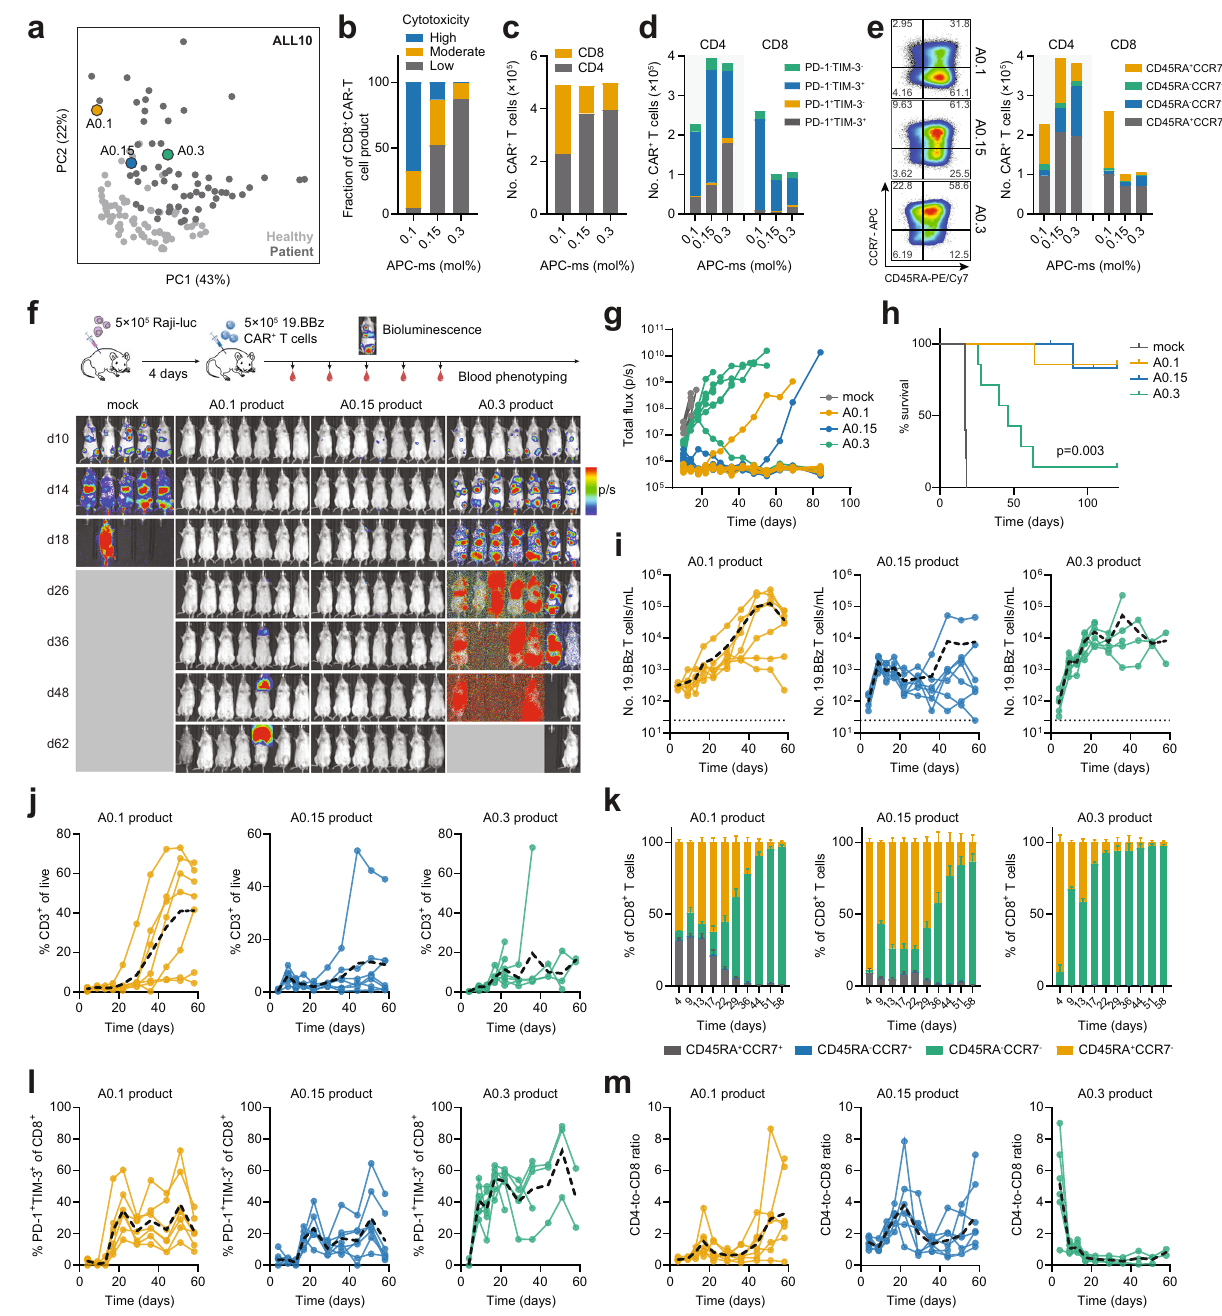
Fig. 3 | Stimulation dose during T-cell activation tunes CAR-T cell responsive- ness in a xenograft lymphoma model. a Selection of APC-ms-primed CAR-T cell products for in vivo analysis. Three CAR-T cell products (0.1mol%, 0.15mol%, and 0.3mol%APC-ms; abbreviated A0.1, A0.15,and A0.3, respectively) derivedfrom an ALL sample (ALL10) were used. Properties of the selected CAR-T cell products, including cytotoxicity classi fi cation ( b ), the number of CD4 + or CD8 + cells ( c ), PD-1 or TIM-3 expressing T cells ( d ), and CD45RA or CCR7-expressing T cells ( e ). Representative FACS plots showing CD45RA and CCR7 expression among CD8 + T cells shown in e ; left. f Study outline of disseminated Raji xenograft model and bioluminescent images showing tumor burden. 5×10 5 luciferized Raji cells were administered four days prior to treatment with 5×10 5 CAR + T cells. CAR-T cell products generatedvia APC-msfrom ALL10 wereusedfortheanimalstudy: